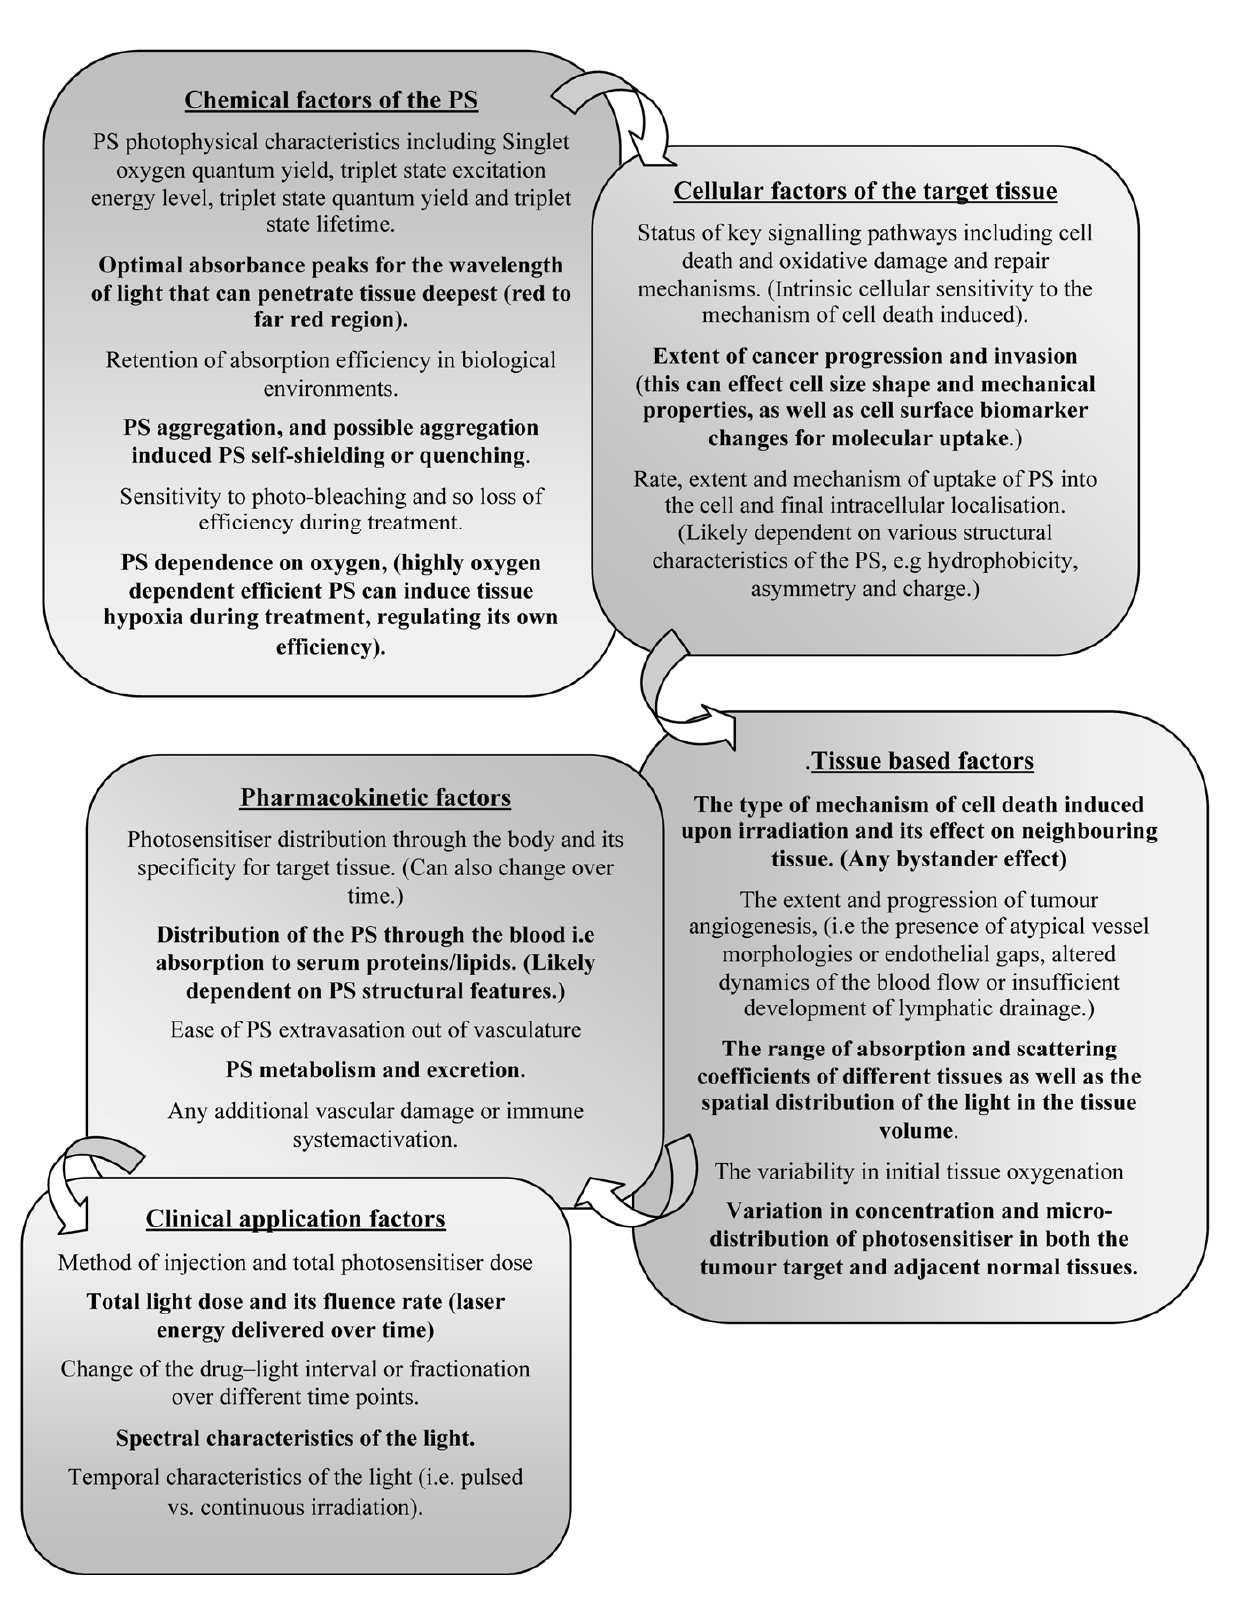
Figure 5. Factors influencing PDT